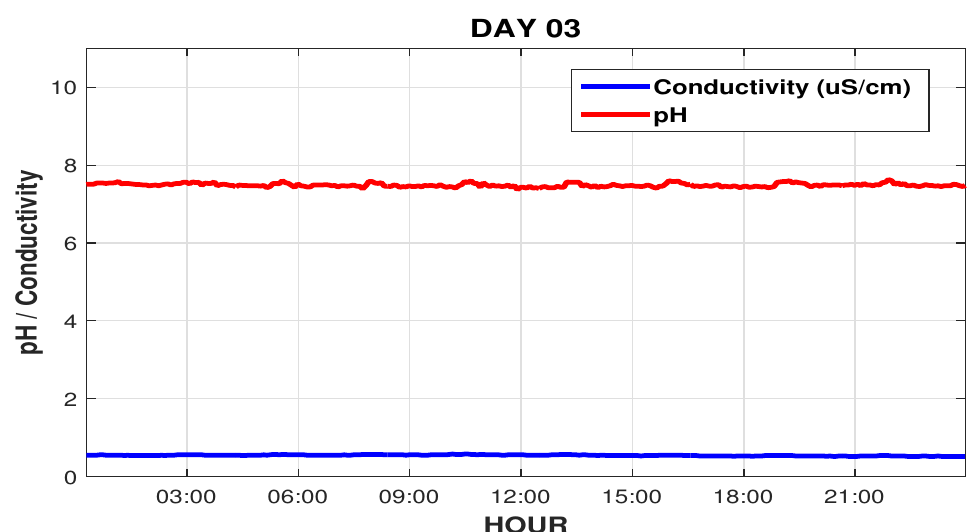
Figure 20. Readings of the PW tank level on the third day.